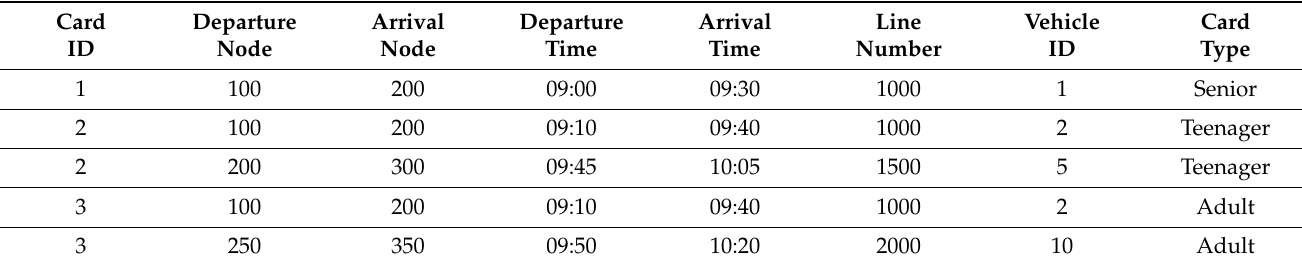
Table 1. Seoul smart card data